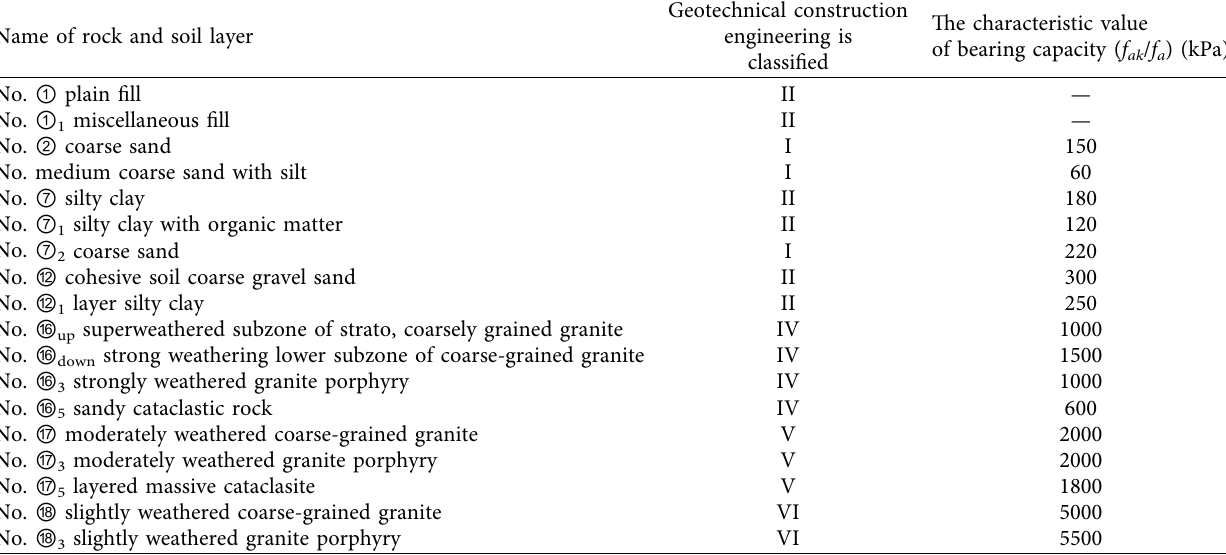
Table 15: Rock and soil construction classification and bearing capacity characteristic value